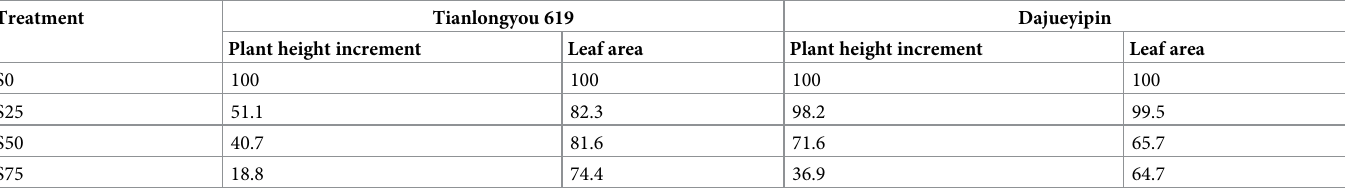
Table 1. Salt tolerance index of aboveground growth indicators of rice